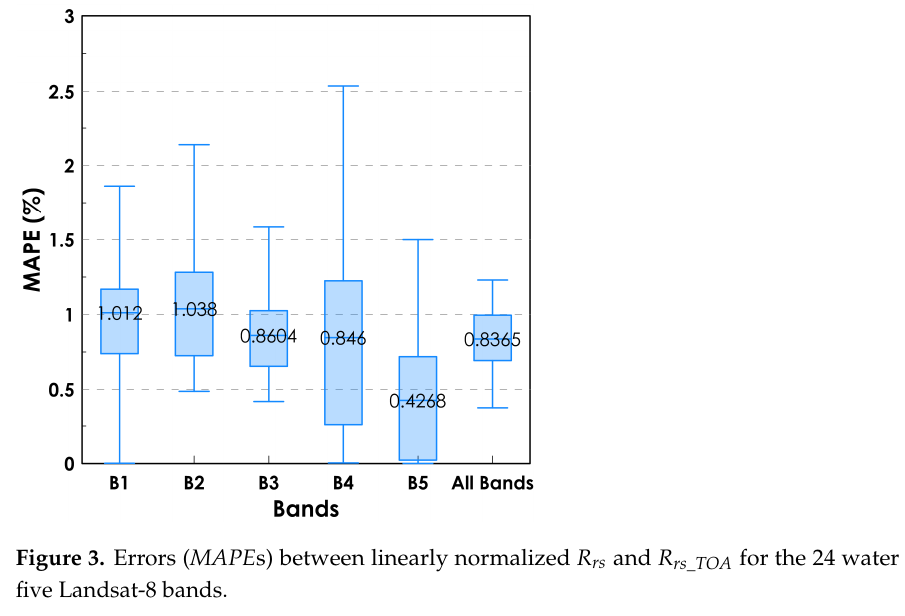
Table 1. The overall correlation coe ffi cient ( r ) of all bands and parameters is r = 0.92. For bands B3, B4, and B5, the correlations ( r = 0.94, 0.95, and 0.96, respectively) were even be tt er than the correlations for bands B1 ( r = 0.86) and B2 ( r = 0.89). Among the fi ve statis- tical parameters, the mean, median, and std show be tt er correlations ( r = 0.95, 0.95, and 0.97, respectively) than the other two parameters, min ( r = 0.87) and max ( r = 0.87). These good correlations imply that we can calculate the statistical parameters of R rs directly from the corresponding parameters of R rs_TOA , without using the atmospheric correction to